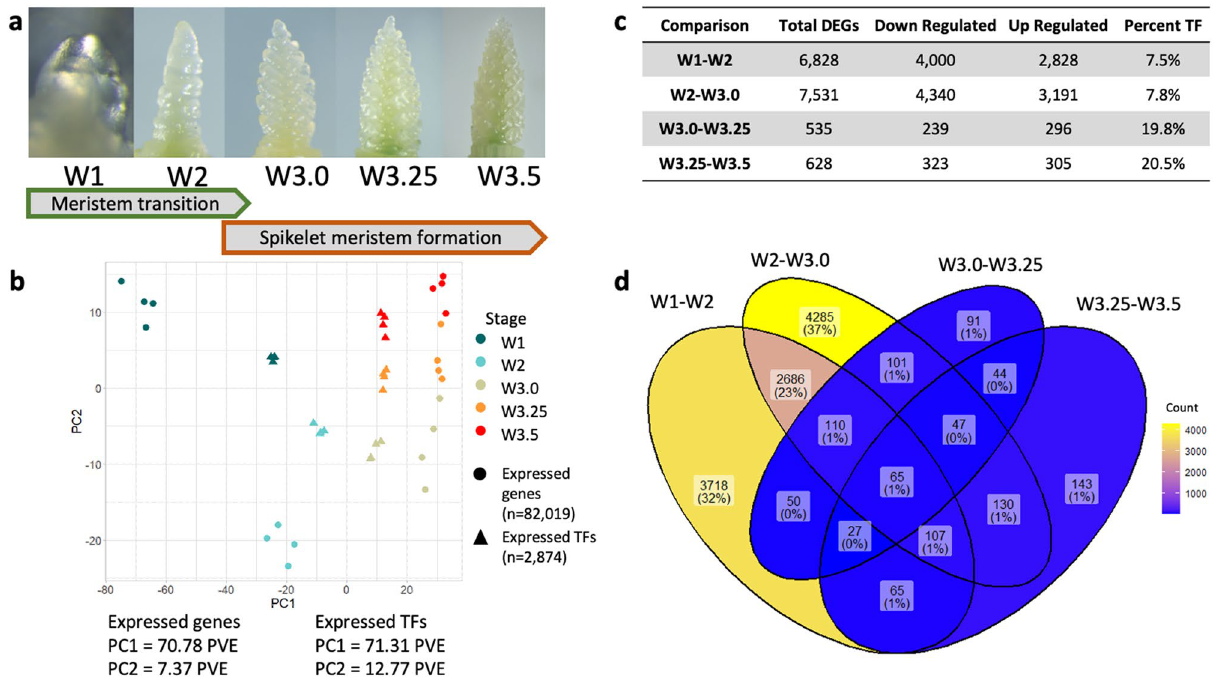
Figure 1. The early wheat inflorescence development transcriptome. ( a ) Sampling stages of Kronos apical meristems according to the Waddington development scale 3 ; W1—vegetative meristem, W2—double ridge, W3.0—glume primordium, W3.25—lemma primordium, W3.5—terminal spikelet. ( b ) Whole transcriptome and transcription factor expression principal component analysis of samples, PC1 plotted on the x-axis and PC2 plotted on the y-axis. PVE -percent variance explained. ( c ) Differentially expressed genes (DEGs) in sequential pairwise comparisons (W1–W2, W2–W3.0, W3.0–W3.25, W3.25–W3.5). The total number of genes, the number up- and down-regulated and the proportion encoding transcription factors (TF) are described. ( d ) Venn diagram of DEGs in each consecutive pairwise comparison from ( c ). Each category is shaded according to the number of sequential DEGs shared among the 4